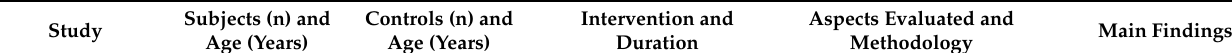
Table 1. Cortical-level studies evaluating supraspinal adaptations using TMS following RT in older